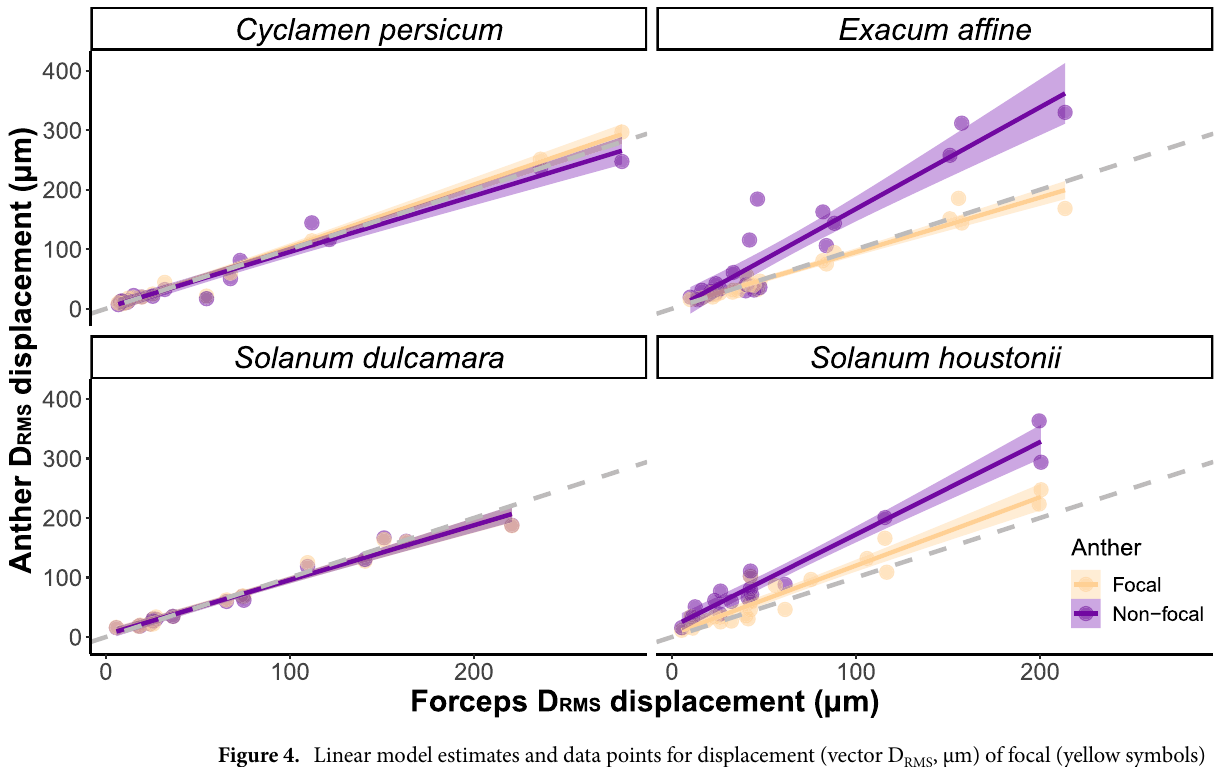
Figure 4. Linear model estimates and data points for displacement (vector D RMS , µm) of focal (yellow symbols) and non-focal anther (purple symbols), against forceps displacement (vector D RMS , µm) in four plant species. Values for the vector are calculated from the x- and y-axes (see “Materials and methods” section for details). Grey dashed line indicates a linear relationship with slope = 1.